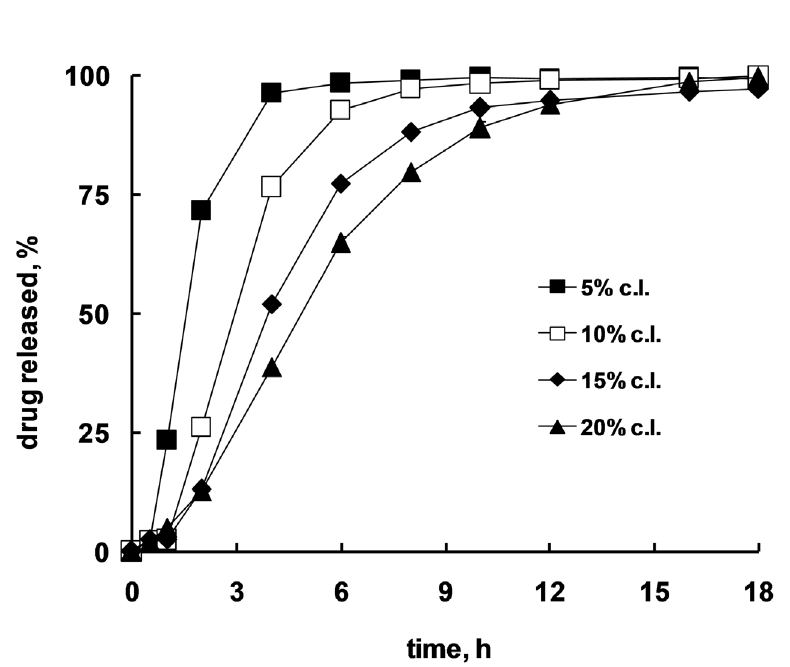
FIGURE 8 - Effect of coating levels on drug release from pellets based on sugar cores loaded with 10% propranolol HCl and coated with a polymer blend of Eudragit ® NE 30D: Aquacoat ® ECD (25:75) using 35%